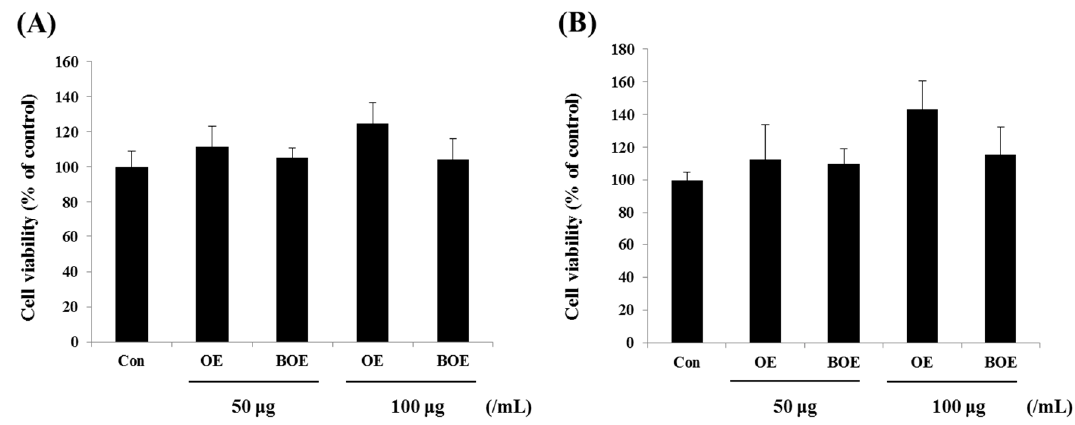
Figure 1. Effects of Orostachys japonicus extract (OE) and bioconverted O. japonicus extract (BOE) on Ms-1 cell viability. Cell viabilities of Ms-1 cells were examined using the MTT assay at 24 h ( A ) or 48 h ( B ) following OE or BOE treatment at the indicated concentrations. Bars represent mean ± SD of three independent experiments. Con, control group.